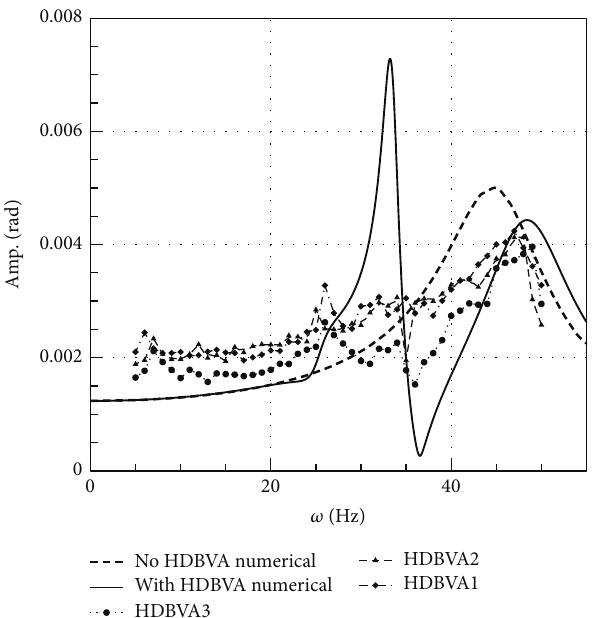
Figure 34: Frequency response of 𝜃 𝑍 DOF of case Figure 10(d), HDBVAs start at the far-from-force